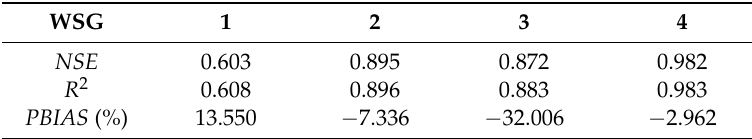
Table 4. Statistical comparison between observed and simulated inflows for WSGs during the validation period.